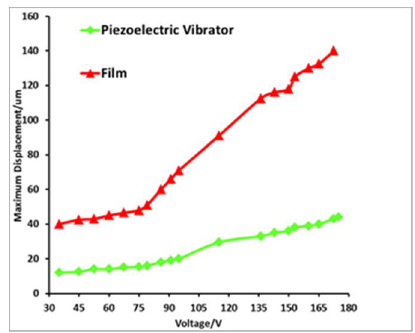
Figure 6. Maximum displacement curve of piezoelectric vibrator and membrane.